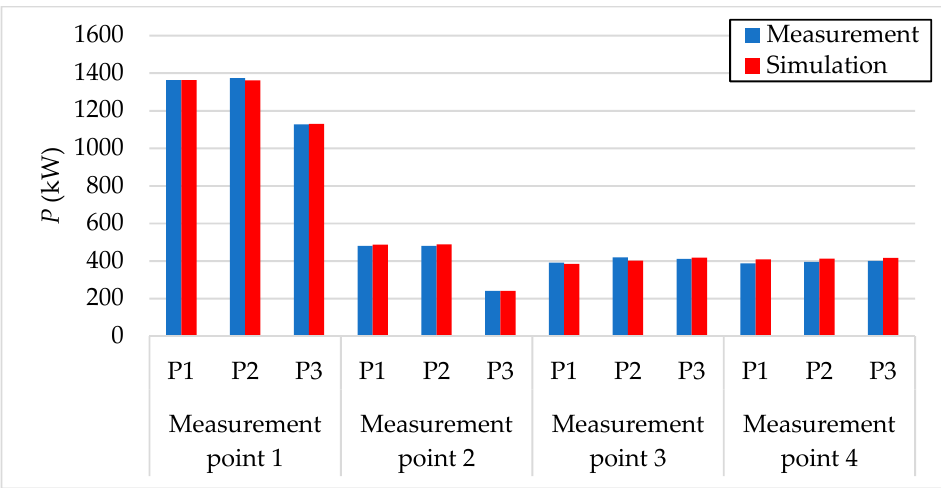
Figure 33. Current levels at the measurement points in the distribution grid.